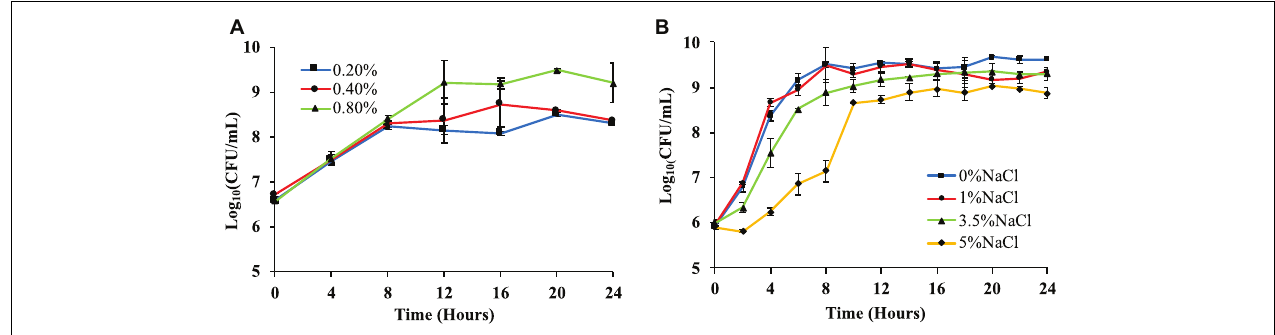
FIGURE 2 | Effects of glucose and NaCl concentrations on the growth rates of Escherichia coli BW25113. (A) E. coli growth curves in 1 × M9 minimal medium with three different glucose concentrations (0.2, 0.4, and 0.8%) measured via logarithmic value of CFU with base 10. (B) E. coli growth curves in LB broth supplemented with four different NaCl concentrations (0, 1, 3.5, and 5%) measured via logarithmic value of CFU with base 10. Three independent replicates were performed for the number of viable cells, the average values and standard error means were used to draw the